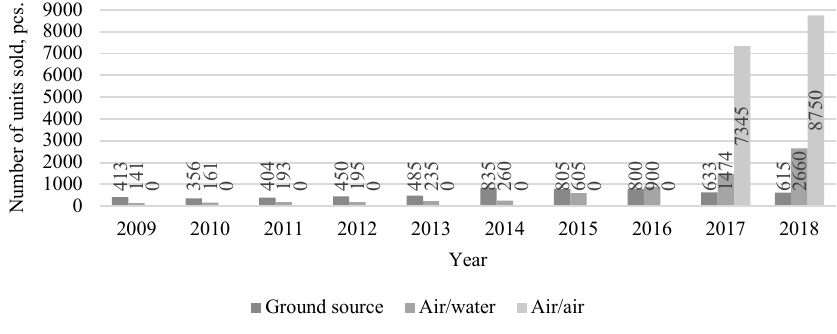
Fig. 12. The number of heat pumps sold in Lithuania by